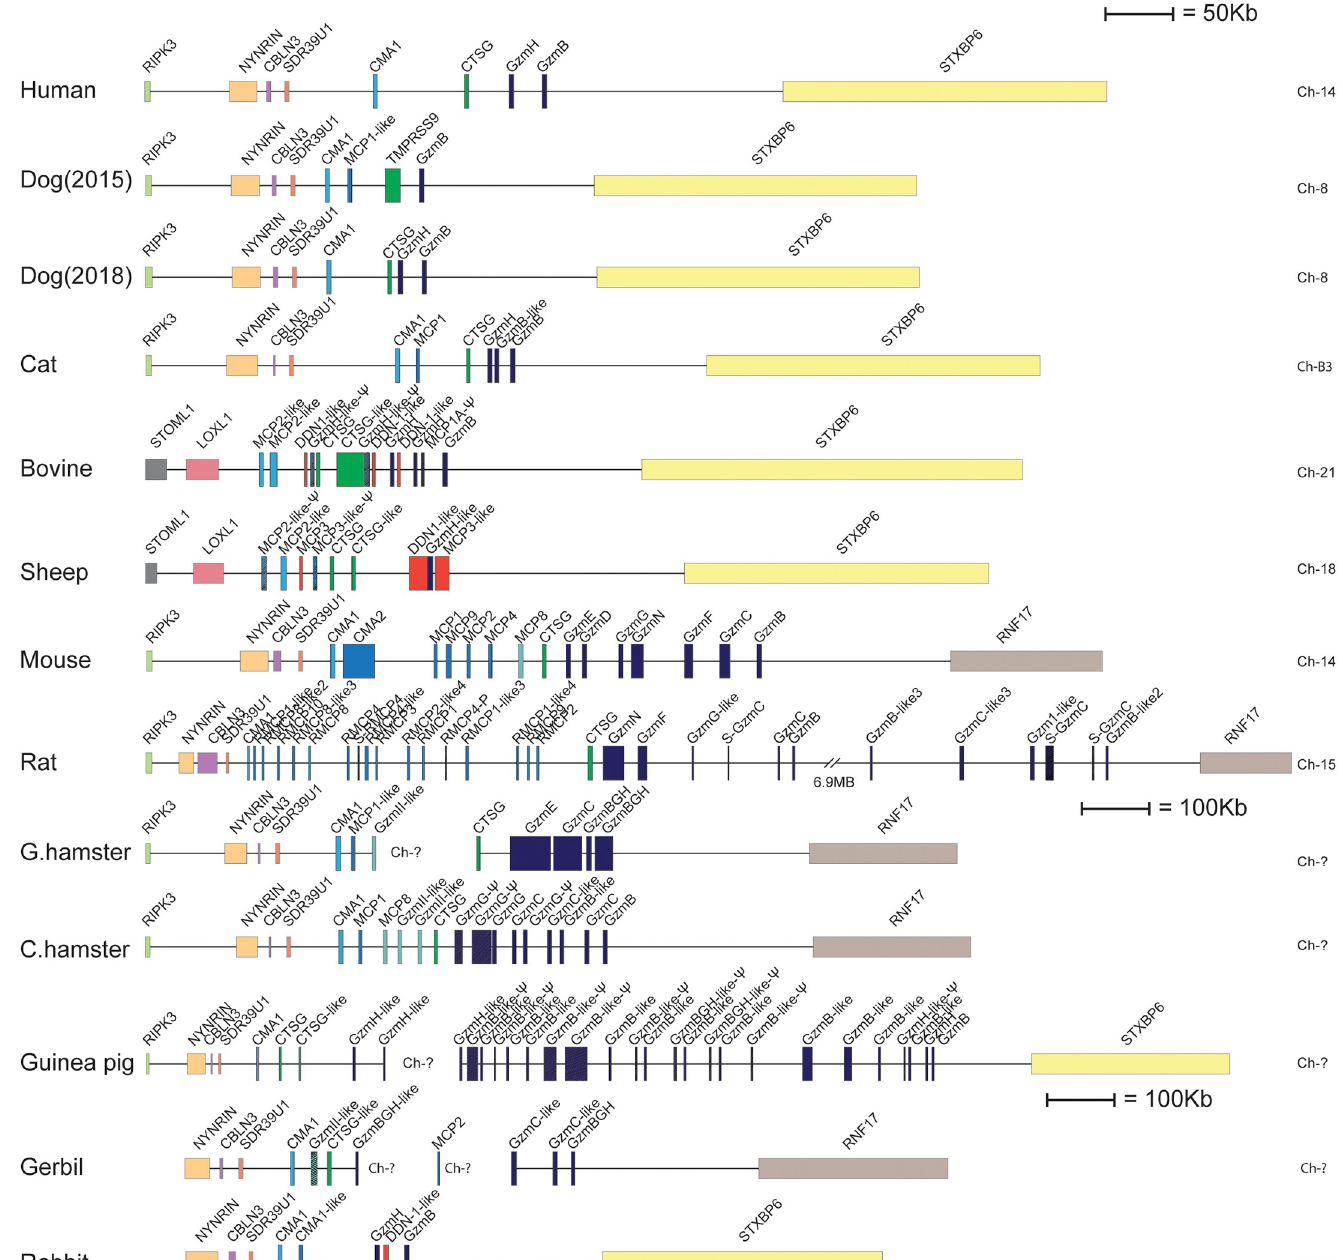
Fig 11. The chymase locus in mammals. A schematic representation in scale of the chymase locus from a panel of placental mammals. This is the locus encoding the α and β -chymases, the mMCP-8 family members, cathepsin G and several of the T cell and NK cell expressed granzymes [6]. The genes are colour coded. Granzymes in dark blue, the α -chymase in light blue, the β -chymases is slightly darker blue, cathepsin G in bright green, the mMCP-8 related proteases in a light blue-green colour and the duodenases of ruminants in red. Bordering genes that help in assigning the locus during genomic screening and for analysis of potential rearrangements in areas close to the locus are depicted in other colours including yellow, light green, grey, purple, pink and orange. The genomic coordinates for the chymase loci presented in this figure are as follows, Human Chr14q12; 24,336,021–24,050,297: Dog—Chr8; 4,305,443–4,877,589: Cat—ChrB3; 76,811,637–77,430,021: Bovine— Chr21; 34,633,172–35,305,932: Sheep—Chr18; 33,488,221–34,143,547: Rabbit—Chr17; 44,437,869–45,028,695: Mouse—Chr14qc3; 55,784,995–56,525,032: Rat— Chr15p13-12; 34,470,796–36,744,750: Golden Hamster—Chr (unknown); 2,447,327–2,618,184 (1): Golden Hamster—Chr (unknown); 12,152,784(RNF17)– 12,397,1608 CTSG)(2): Chinese Hamster—Chr (unknown); 451,470(RNF17)–929,914